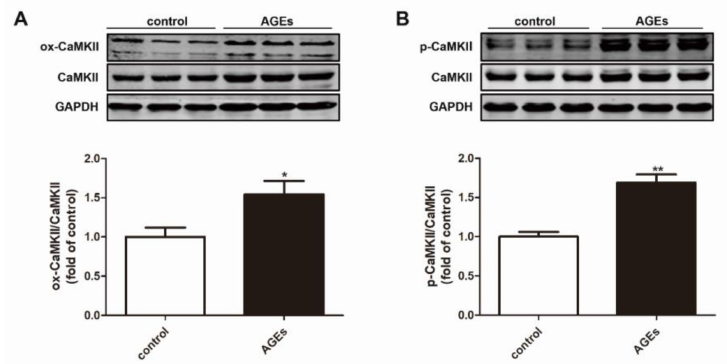
Figure 4. AGEs promoted CaMKII activation in cardiomyocytes. Cardiomyocytes were stimulated with AGEs (200 µ g/mL) for 24 h. ( A ) The expression of ox-CaMKII and CaMKII was detected by Western blot in cardiomyocytes. GAPDH was used as a loading control. ( B ) The expression of p-CaMKII and CaMKII was detected by Western blot in cardiomyocytes. GAPDH was used as a loading control. Plots represent the mean ± SEM; n = 6. Statistical significance: * p < 0.05, ** p < 0.01 compared with